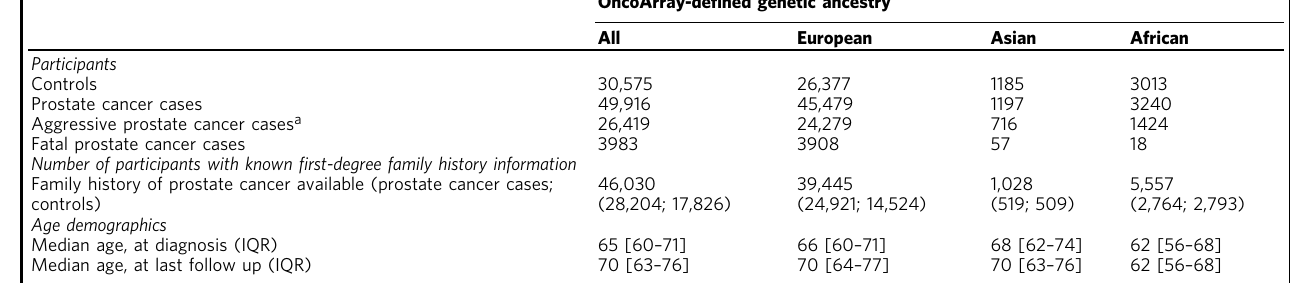
Table 6 Participant characteristics, n =